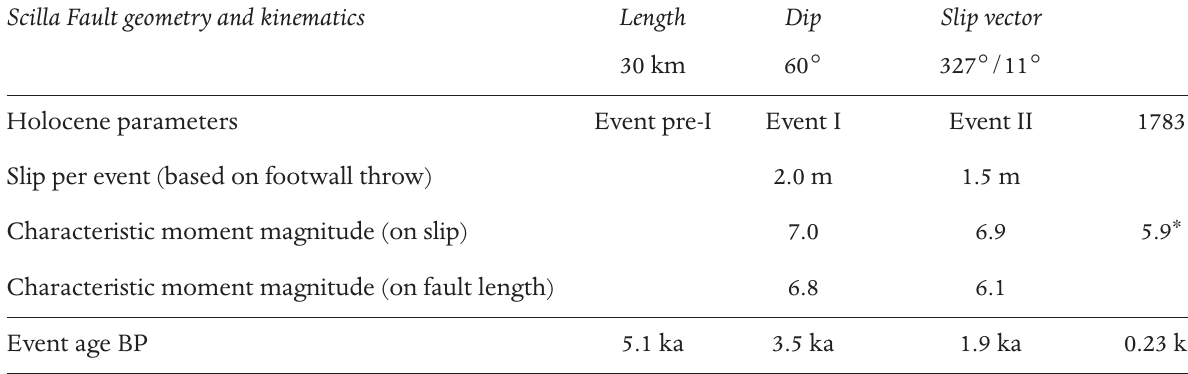
Table 6. Geometric and kinematic parameters for the Scilla Fault based on the displacement record of Late Holocene shorelines and fault length [modified after Ferranti et al. 2008]. *Macroseismic estimate from CPTI Working Group